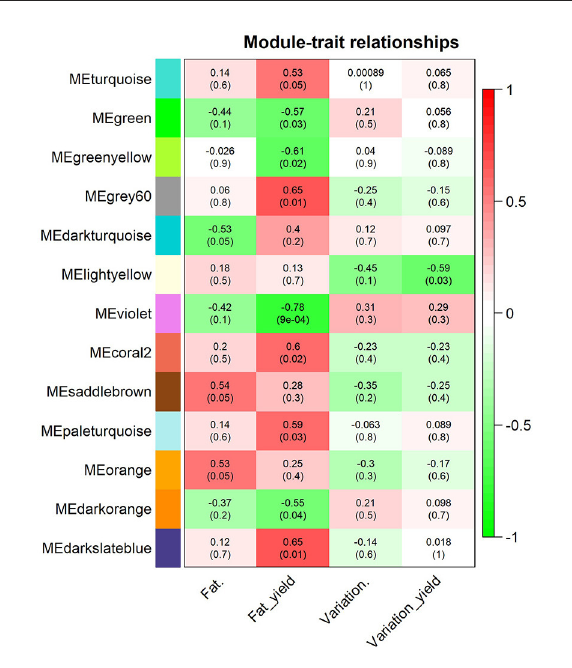
FIGURE3 Significant module-trait associations found between the module eigengenes (ME) and the milk-fat traits analyzed [fat percentage (Fat.), fat yield (Fat_yield), variation in fat percentage (Variation.), and variation in fat yield (Variation_yield)]. Each row corresponds to a module eigengene labeled with colors and each column to a milk fat trait. Individual cells contain Pearson’s correlation coefficients (outside parentheses) and the P -values of the correlation (within parentheses). The red to green color within the cells represents the positive (red) or negative (green) correlation of the modules with the milk fat